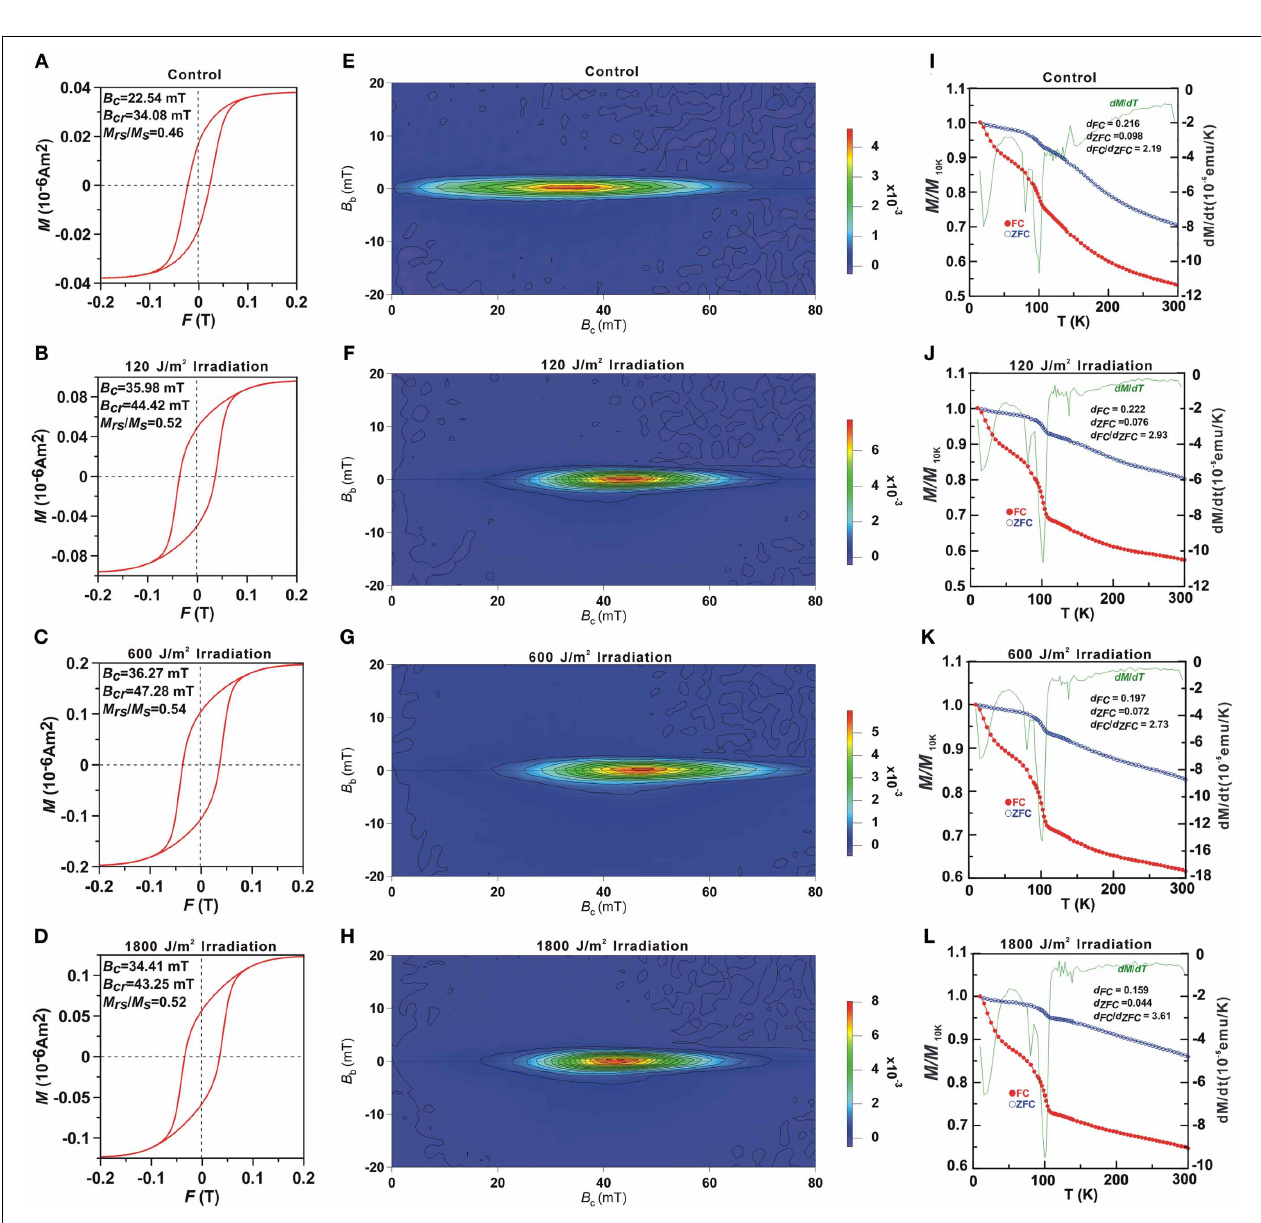
FIGURE 5 | Room temperature hysteresis loops (A–D), FORC diagrams (E–H) and low temperature magnetization curves (I–L) of the control and the irradiated cell bulk samples. In (I–L) the red, blue and green lines represent the FC, ZFC curves and first derivative of FC curves,